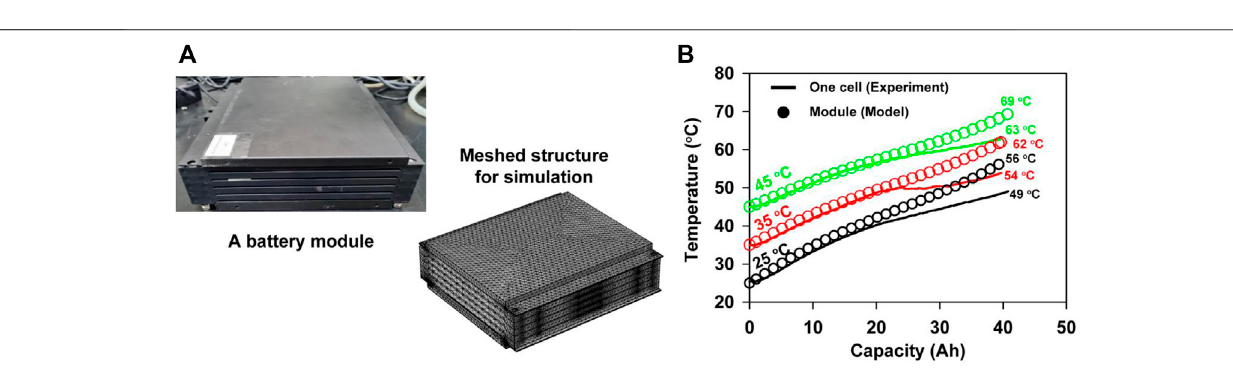
Frontiers in Materials |